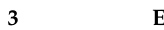
Table 1. Example of extraction of the number of vegetables